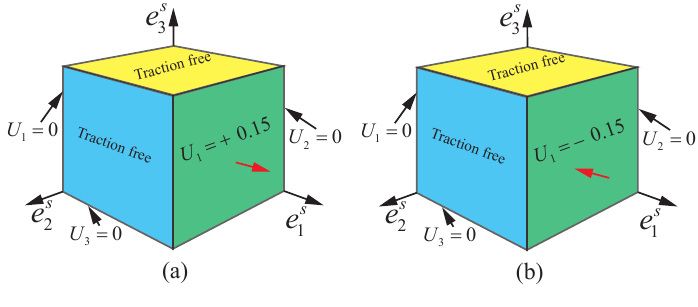
Figure 3. Finite element models subjected to ( a ) tension and ( b )